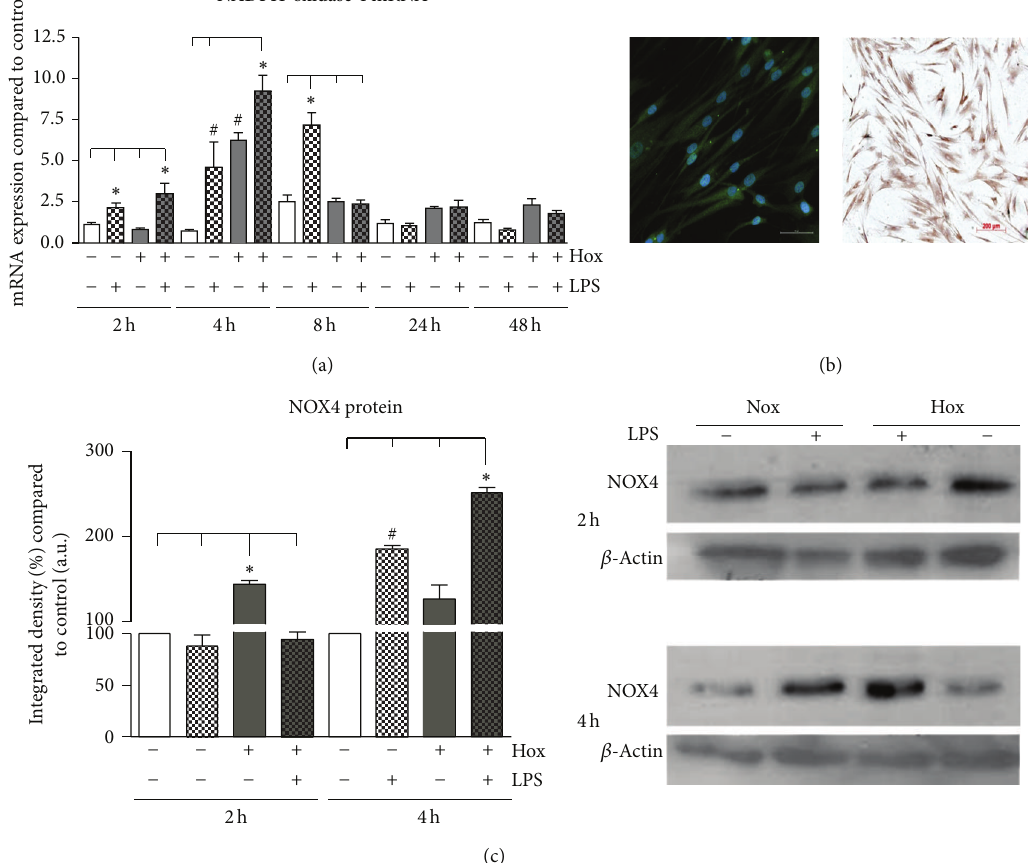
Figure 1: NOX4 in human primary periodontal ligament (PDL) cells. (a) PDL cells were cultured under normoxic or hypoxic condition and stimulated with or without LPS of Porphyromonas gingivalis (1 𝜇 g/mL). NOX4 mRNA expression was analyzed after 2, 4, 8, 24, and 48 h. Statistical differences were analyzed by one-way ANOVA and post hoc Dunnett and Tukey’s multiple comparison test; # 𝑃 < 0.05 difference to control; ∗ 𝑃 < 0.05 difference between groups (means ± SD; 𝑛 = 9 ). (b) NOX4 protein was visualized by immunofluorescence as well as immunohistochemical staining in unstimulated PDL fibroblasts (1: 50; antibody from Abcam). (c) Immunoblot data of NOX4 in PDL cells cultured under normoxic or hypoxic condition (Hox) and stimulated with or without LPS of Porphyromonas gingivalis (1 𝜇 g/mL). NOX4 protein levels were analyzed after 2 and 4h. Statistical analysis of western blot data was performed using the freely available image-processing software ImageJ 1.43 (http://rsb.info.nih.gov/ij/). Statistical differences were analyzed by one-way ANOVA and post hoc Dunnett and Tukey’s multiple comparison test; # 𝑃 < 0.05 difference to control; ∗ 𝑃 < 0.05 difference between groups (means ± SD; 𝑛 = 3 ). The scale bars indicate 200 𝜇 m in the bright field survey and 50 𝜇 m in the immunofluorescence image,